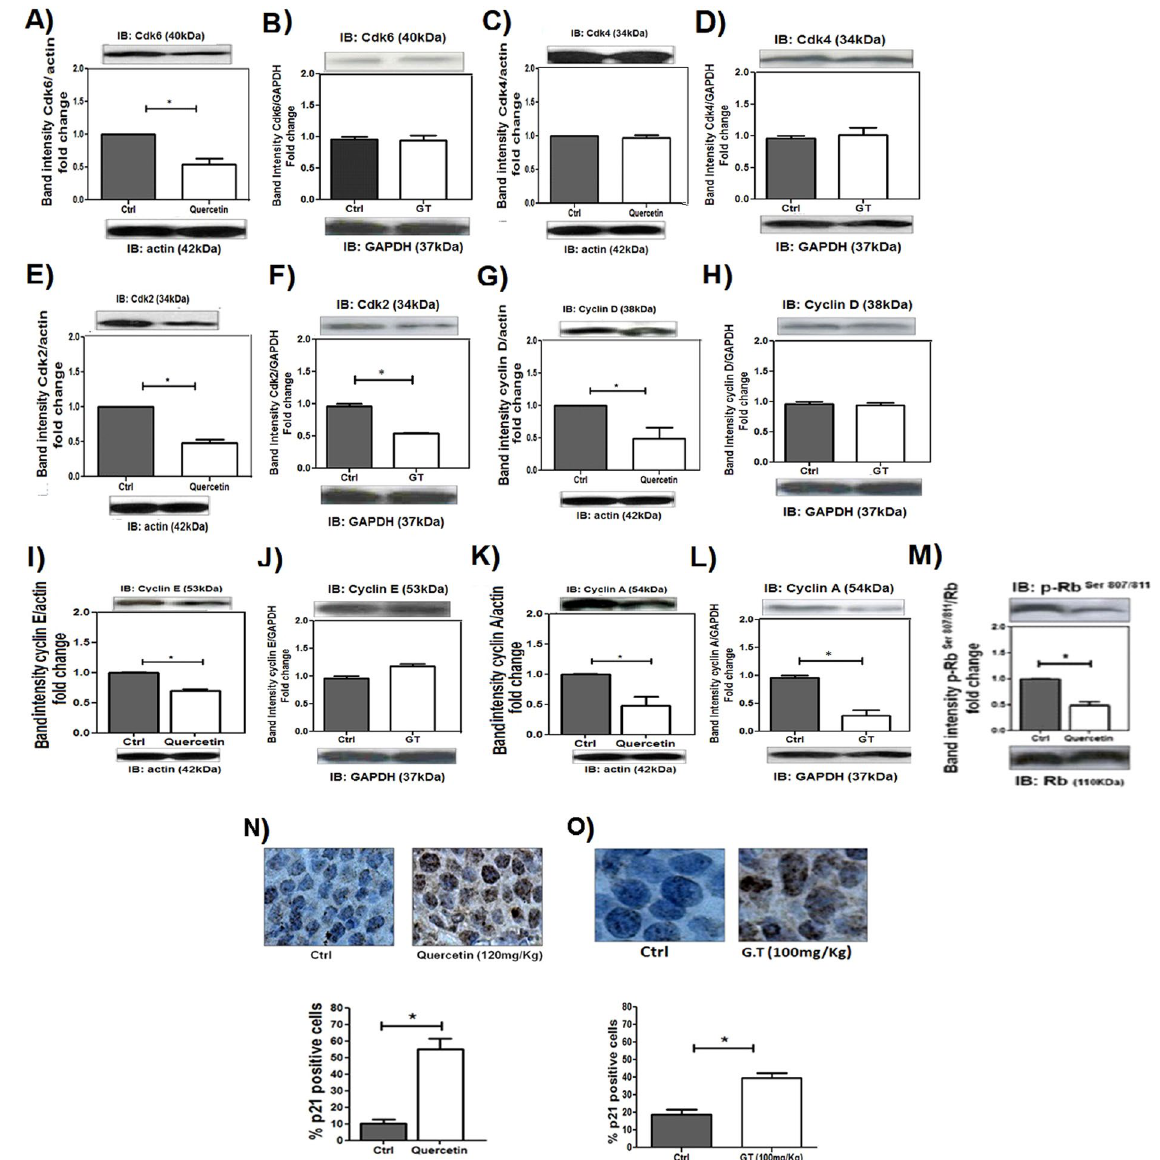
Figure 3. Quercetin and Green Tea induces arrest of the G1 phase of cell cycle in HL-60 xenografts. NOD/SCID mice with HL60 tumors received or not quercetin (120 mg/kg), once every 4 days or green tea (100 mg/kg), every day. After 3 weeks, tumors were harvested and relative levels of protein in the tumor lysates were determined by Western blotting; ( A , B ) CDK6; ( C , D ) CDK4; ( E , F ) CDK2; ( G , H ) CYCLIN D; ( I , J ) CYCLIN E; ( K , L ) CYCLIN A; ( M ) p-RB. ( N , O ) IHC analysis of p21 protein in tumor sections and the percentage of p21-positive nuclei of cells per field; four fields per tumor section. Counts were performed using x40 objective connected to a light microscope (Olympus CBA; Olympus America). Values are means ± SD (mean of 6 mice/ group); * P <